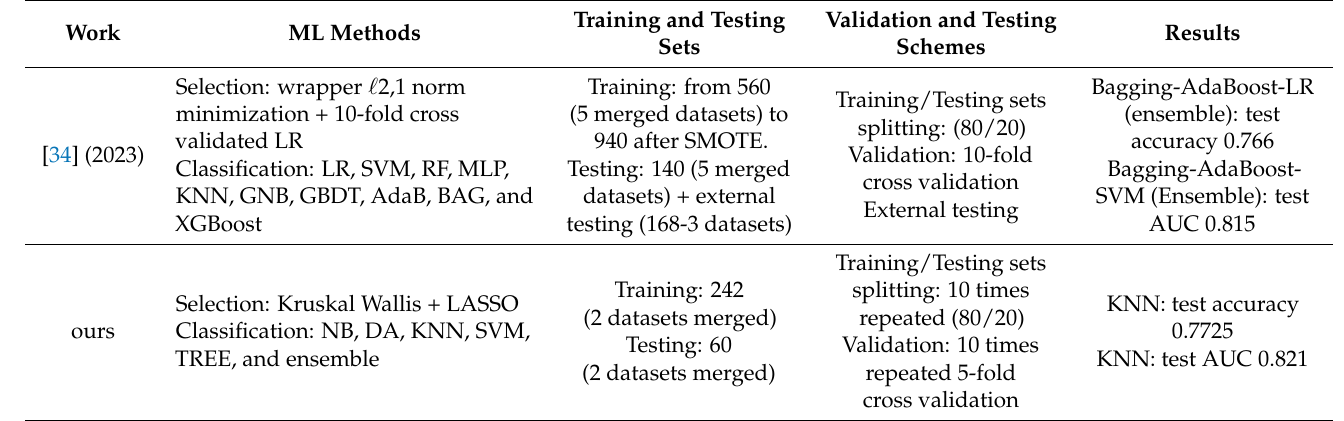
Table 7. Multiclass classification comparison between works, in which machine learning methods, validation and testing schemes, and the best averaged results are reported. Acronyms: least ab- solute shrinkage and selection operator (LASSO), Naïve Bayes (NB), K-nearest neighbors